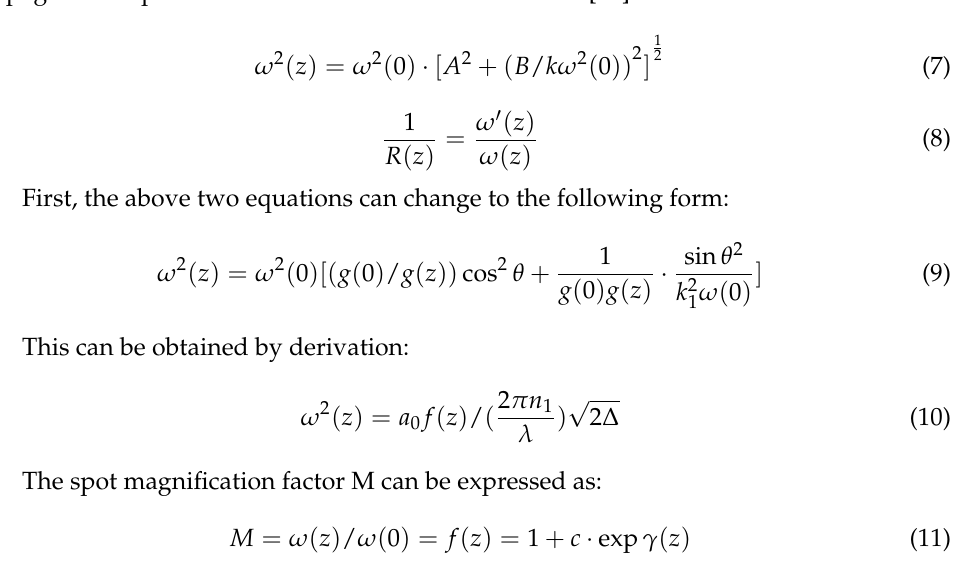
Figure 4. Optical path analysis of waist-enlarged bitaper in SMBMS MZI. The propagation response characteristics of Gaussian beams in tapered fibers are given by the spot size ω (z) and the wavefront curvature radius R(z), used to describe the propagation response characteristics of Gaussian beams